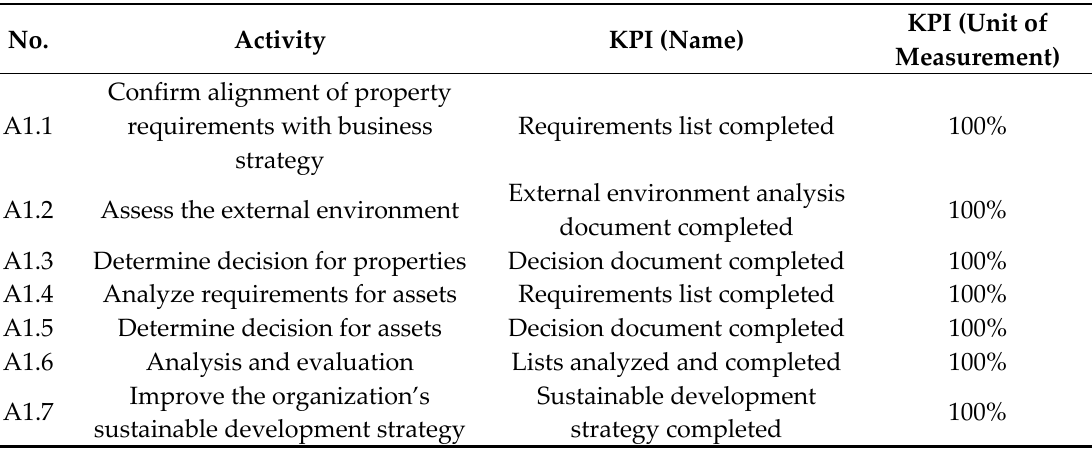
Table 4. P1 process-future state.